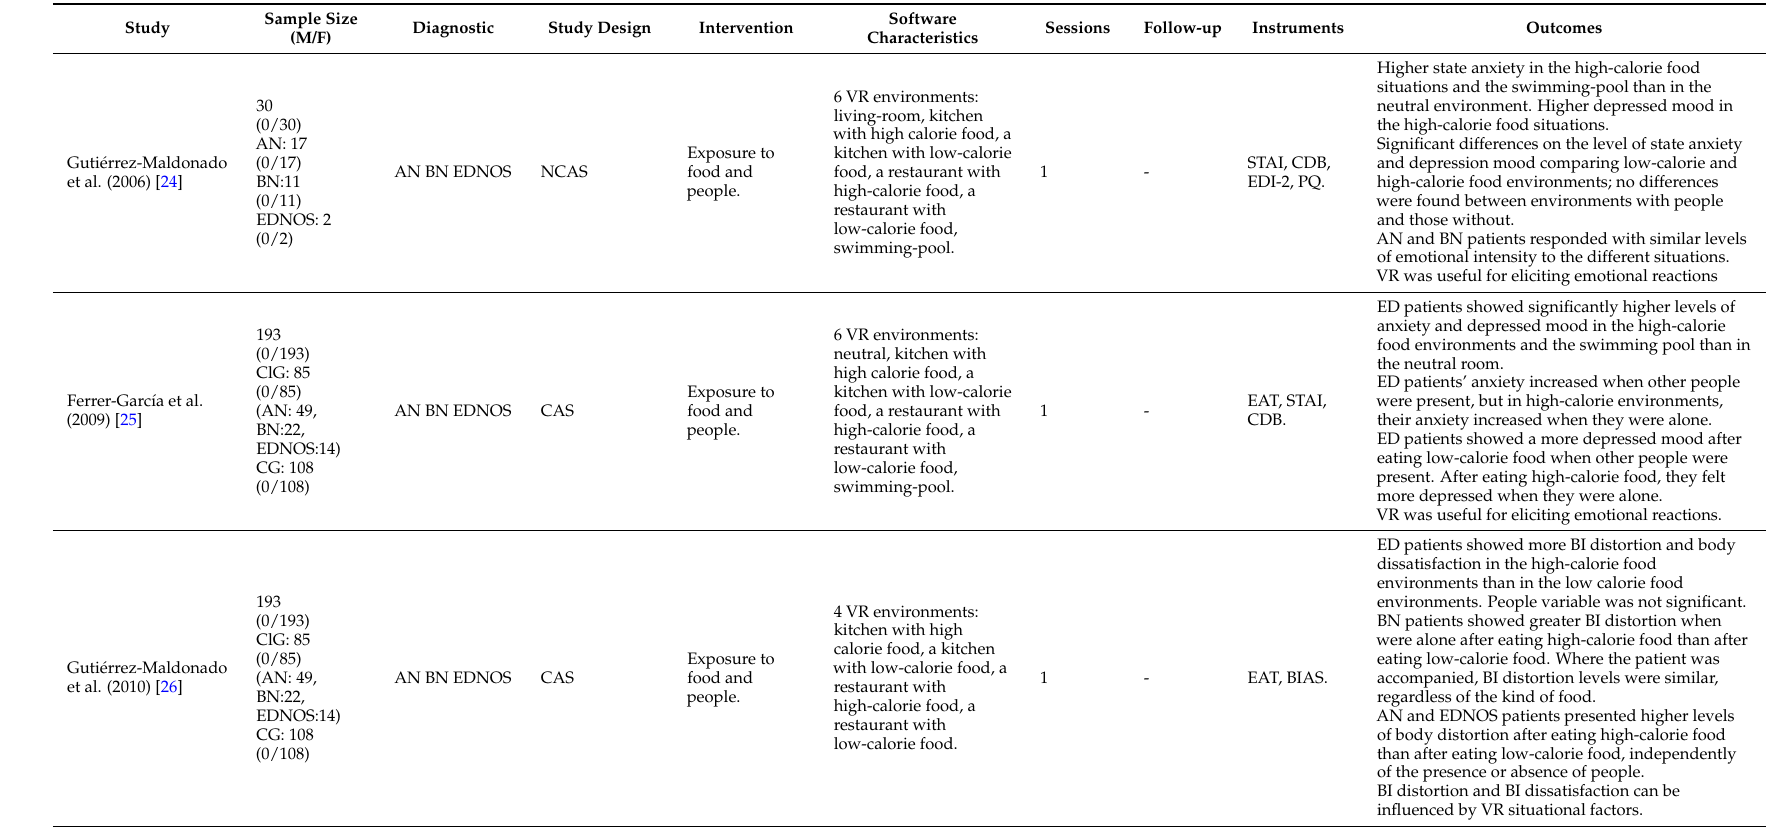
Table 1. Studies using virtual reality in the assessment of bulimia nervosa and binge eating